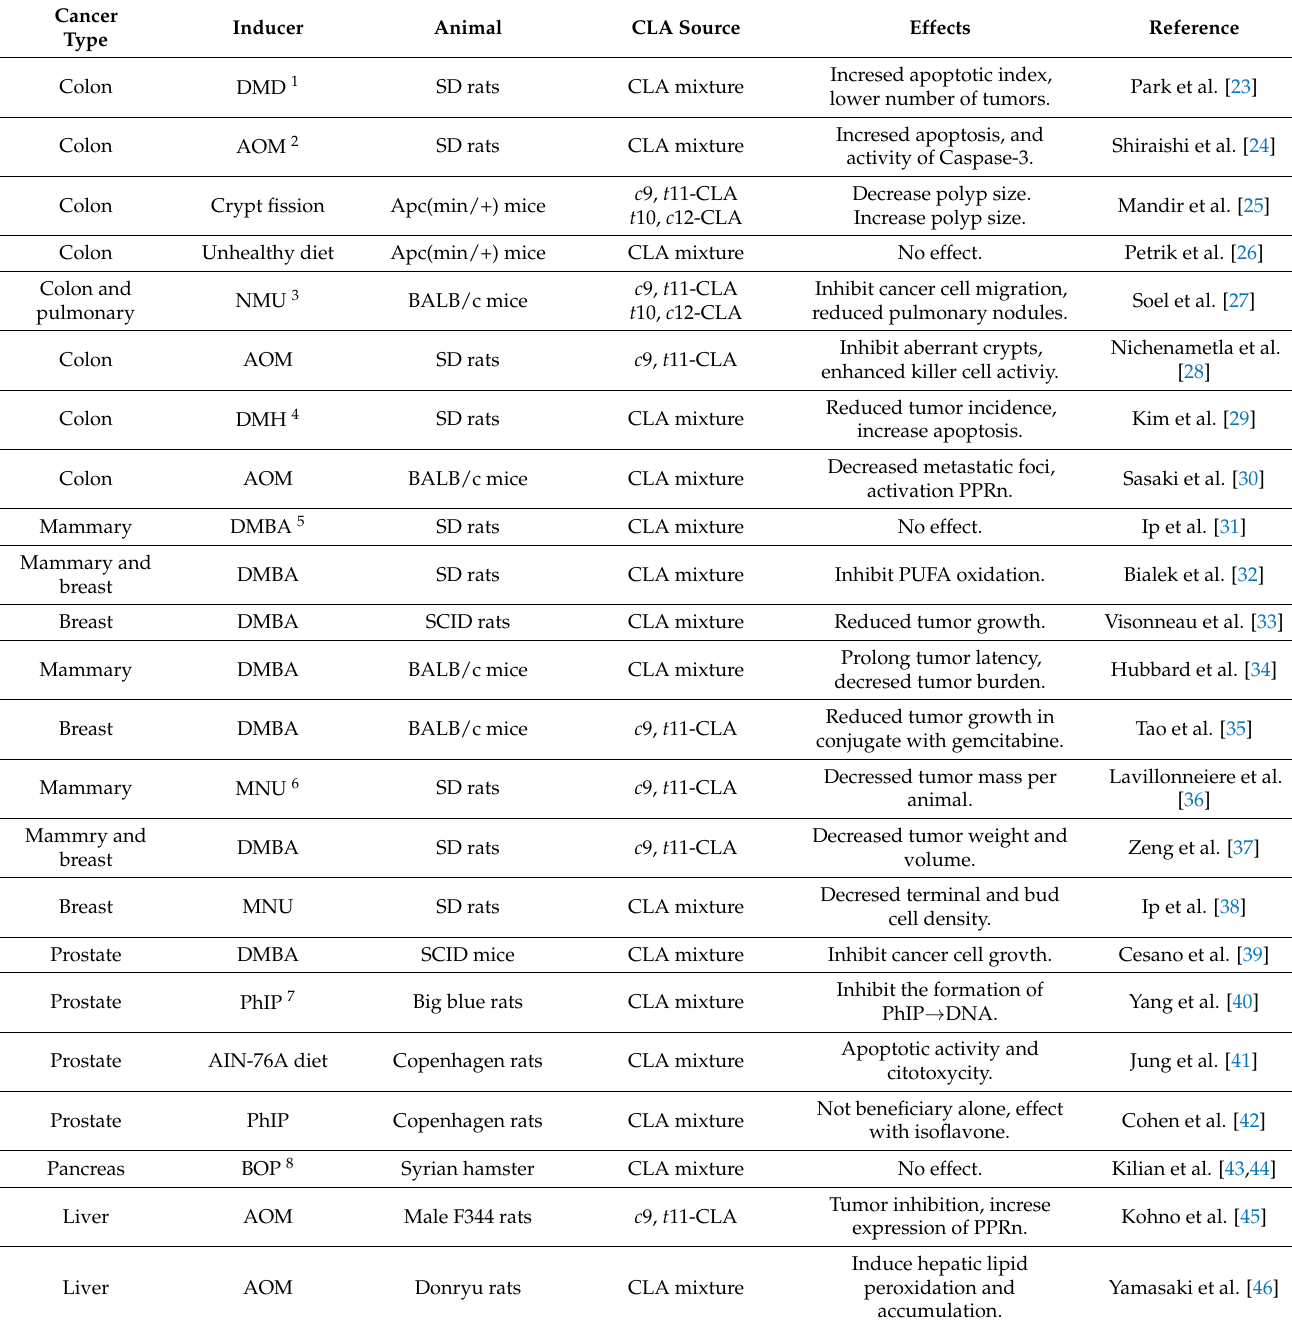
Table 1. Effects of conjugated linoleic acids (CLA) in carcinogenesis (animal